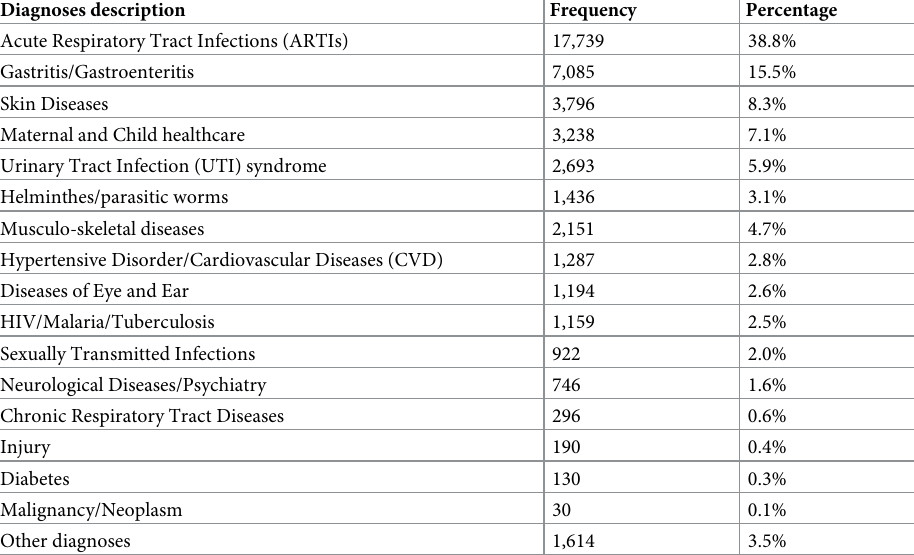
Table 3. Frequency of patient diagnoses at the study clinics between April 1 and December 27, 2016, in Nairobi, Kenya (N = 45,706